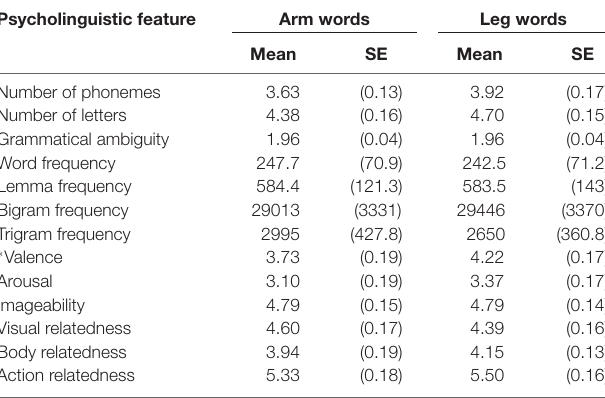
TABLE 1 | Means and standard deviations of psycholinguistic properties for arm and leg